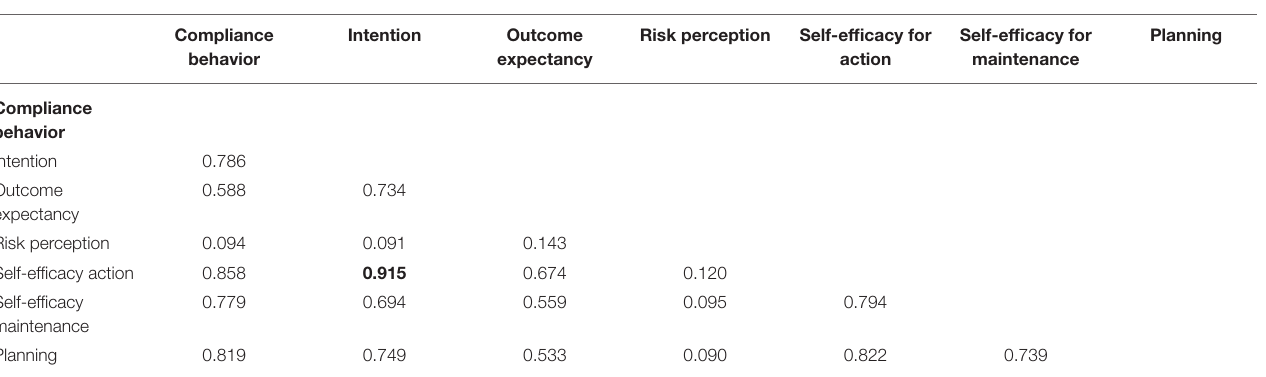
TABLE 6 | Discriminant validity—Heterotrait-monotrait ratio